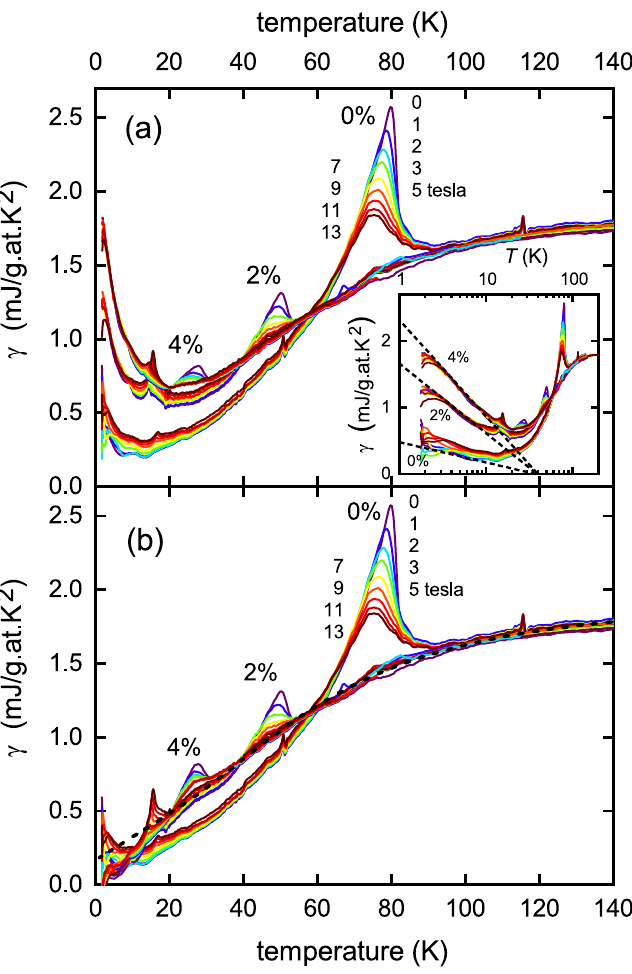
Figure 1. ( a ) The measured electronic specific heat coefficient γ( T ) for YBa 2 Cu 4 O 8 for 0%, 2% and 4% planar Zn concentration at 0, 1, 2, 3, 5, 7, 9, 11 and 13 tesla. The same colour coding is used for each sample. Inset: the same data plotted versus ln ( T ) highlighting the impurity scattering term (dotted lines). ( b ) the same data with the impurity term subtracted. The black dashed curve is the fitted normal-state specific heat coefficient, γ n which satisfies entropy